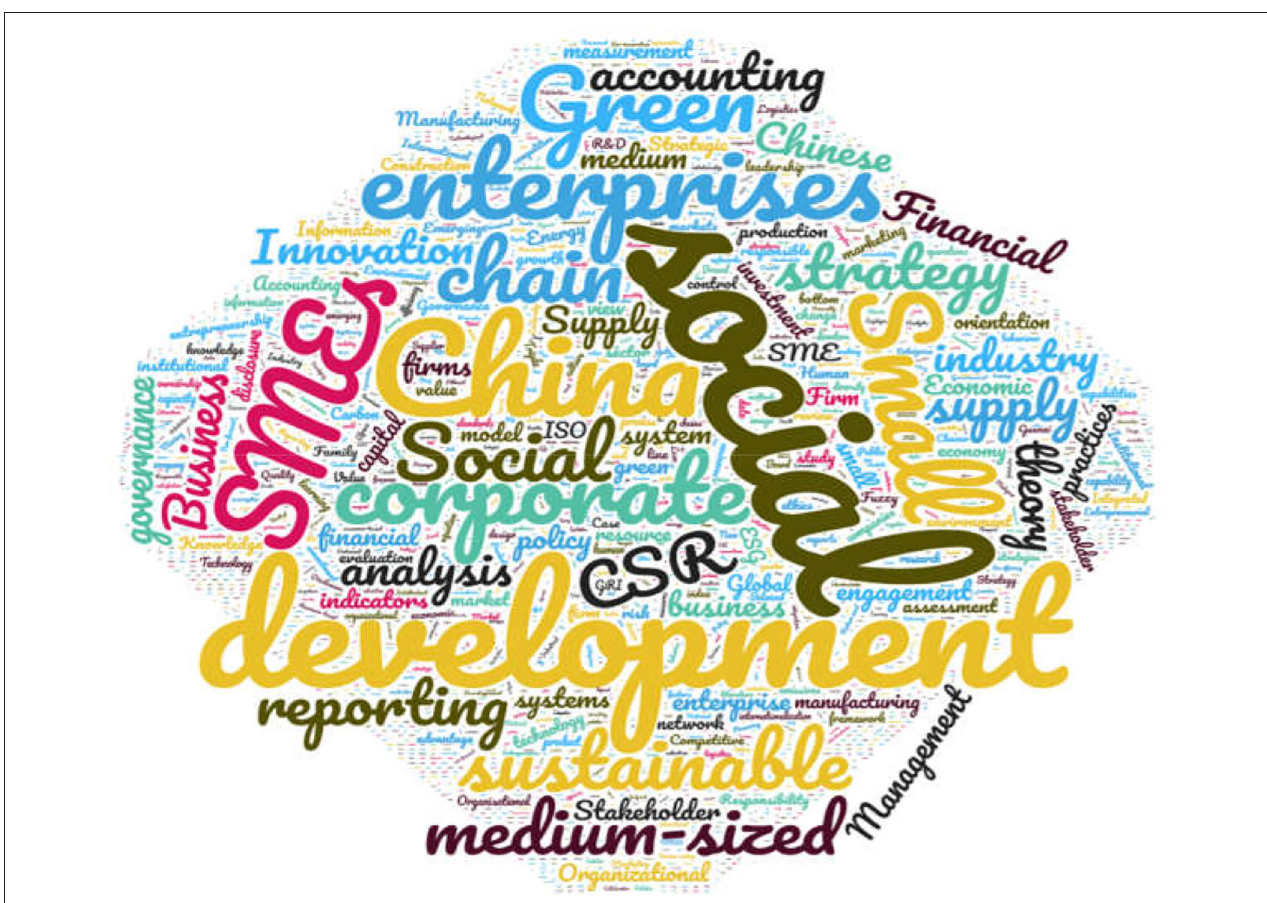
FIGURE 1 | World cloud from keywords of relevant research